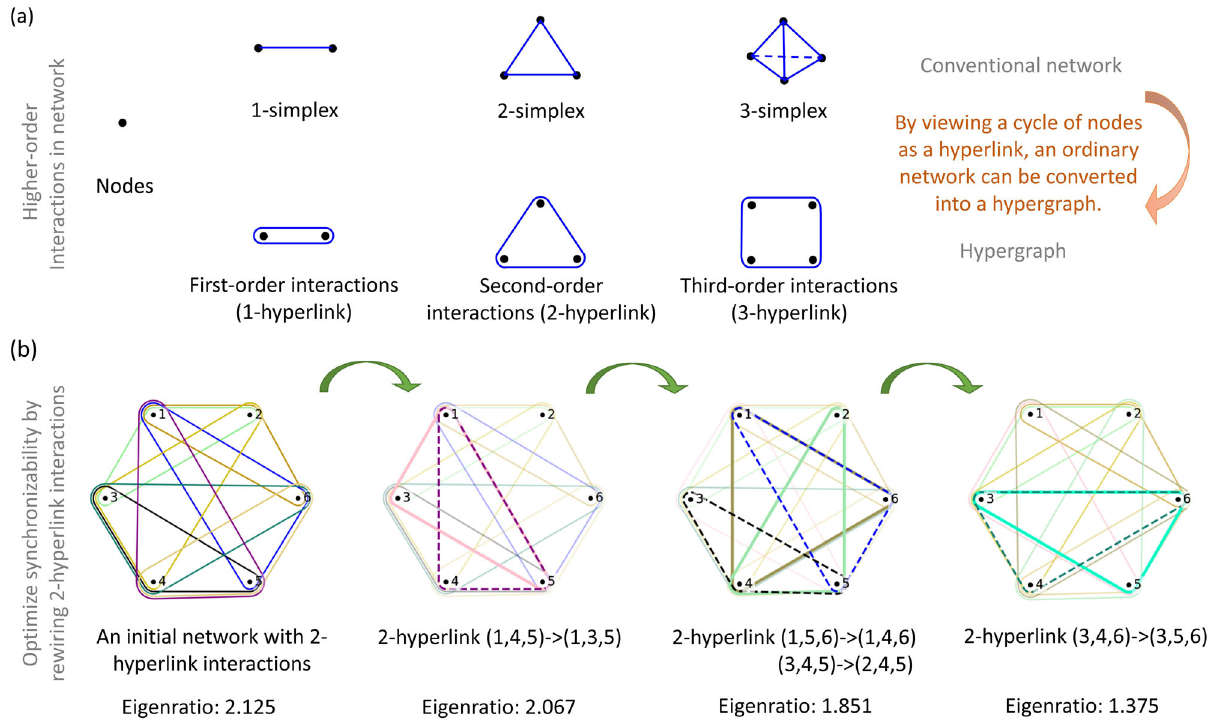
Fig. 1 Schematic on optimizing synchronizability of the network with undirected higher-order interactions. The present higher-order interactions are from hyperlinks, similar as the simplex interactions 28 . a Various orders of interactions, such as 1-hyperlink, 2-hyperlink, etc. The 2-hyperlink is an interaction among three nodes on hypergraphs, which is the present major focus. b An illustration on optimizing synchronizability for a network with undirected 2-hyperlink interactions. An initialized network with 6 nodes (numbered from 1 to 6) and 8 2-hyperlinks is rewired to optimize its synchronizability, by minimizing the eigenratio of the generalized Laplacian. The colored triangles denote 2-hyperlink interactions, and are put on top of each other with shifting their positions for visualization. The rewiring process keeps the number of 2-hyperlinks constant, by deleting a few 2-hyperlinks and randomly adding the same number of 2-hyperlinks, as speci fi ed by the triplets and the arrow between them, e.g., (1, 4, 5) → (1, 3, 5). At each step, the deleted triangles have dashed lines, and the added triangles have thicker solid lines. The procedure fi nds the network topology with smaller eigenratios and better